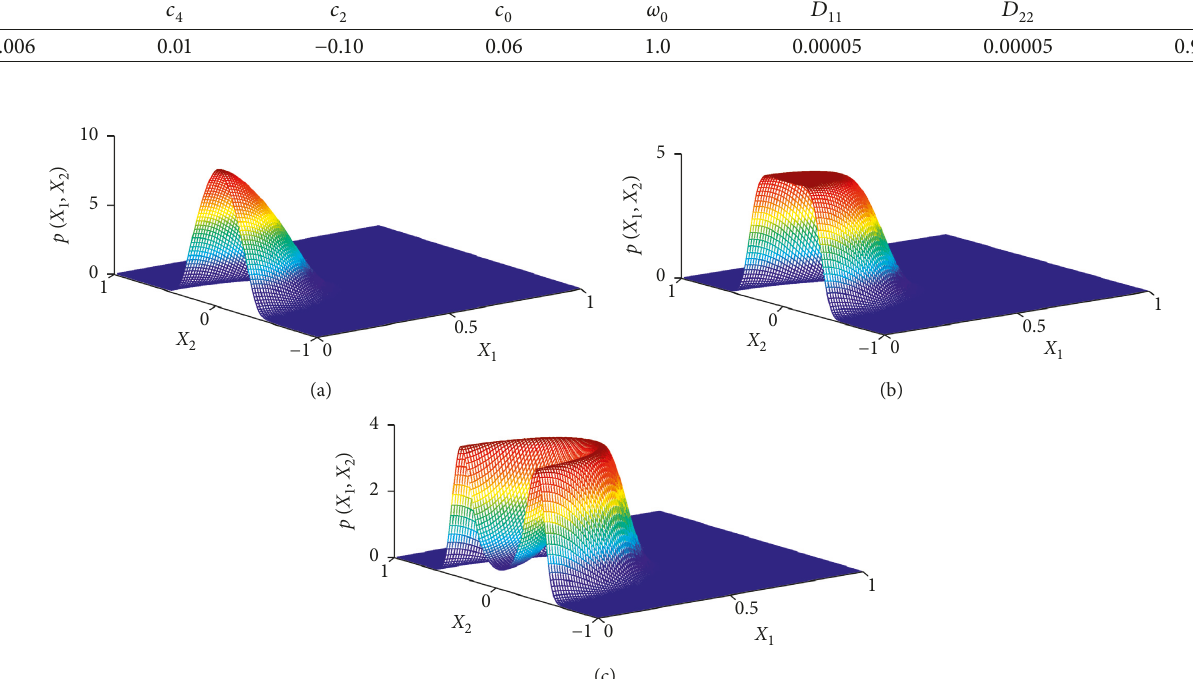
Figure 7: The joint probability density functions for different α . (a) α � 0 . 6. (b) α � 0 . 5. (c) α � 0 . 3.